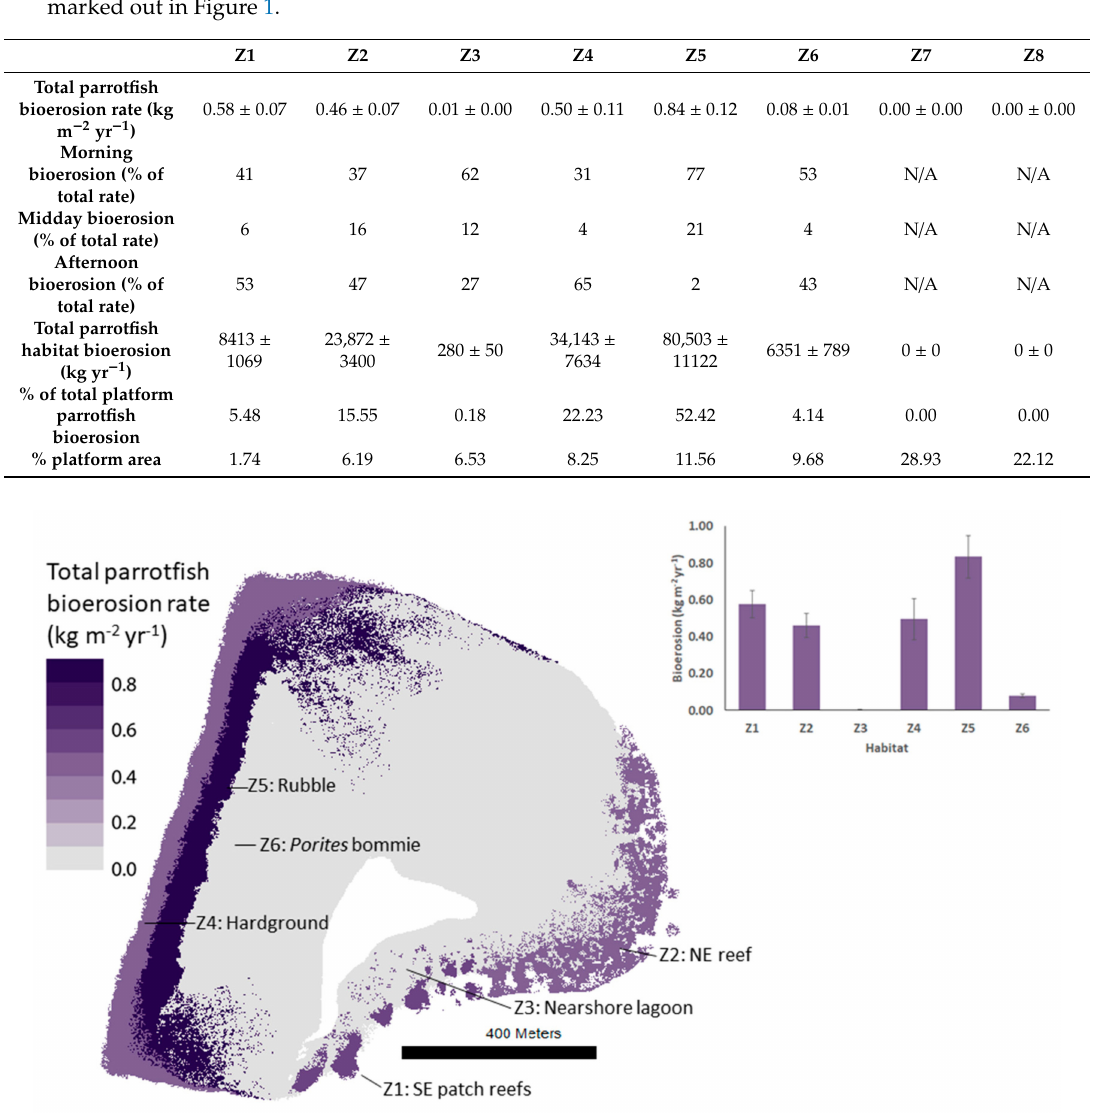
Figure 3. Choropleth map showing total rate of parrotfish bioerosion in each marine habitat on the Vavvaru platform. Bar graph subplot shows habitat bioerosion rates and standard